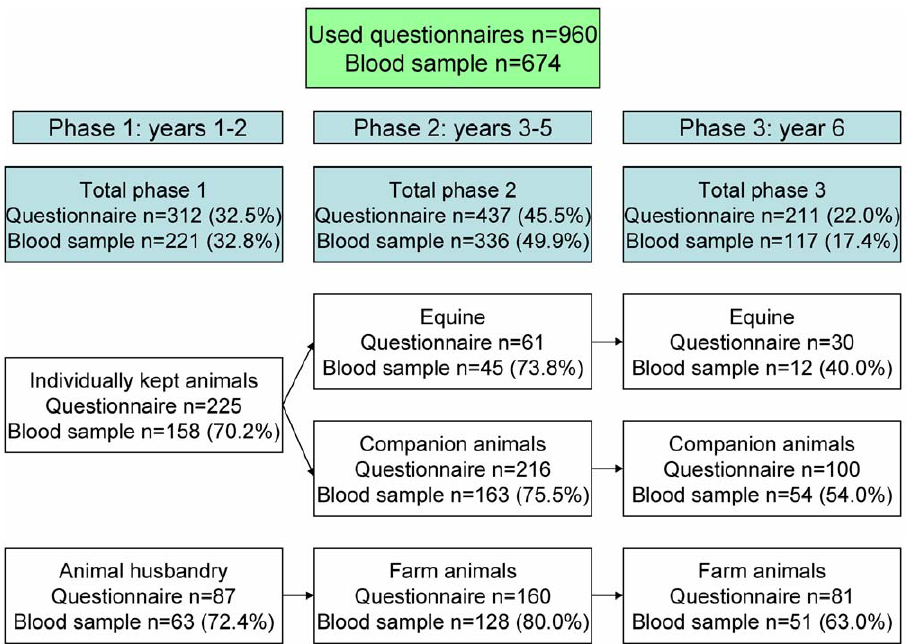
Figure 1. Numbers and percentages of participants per study direction and study phase.